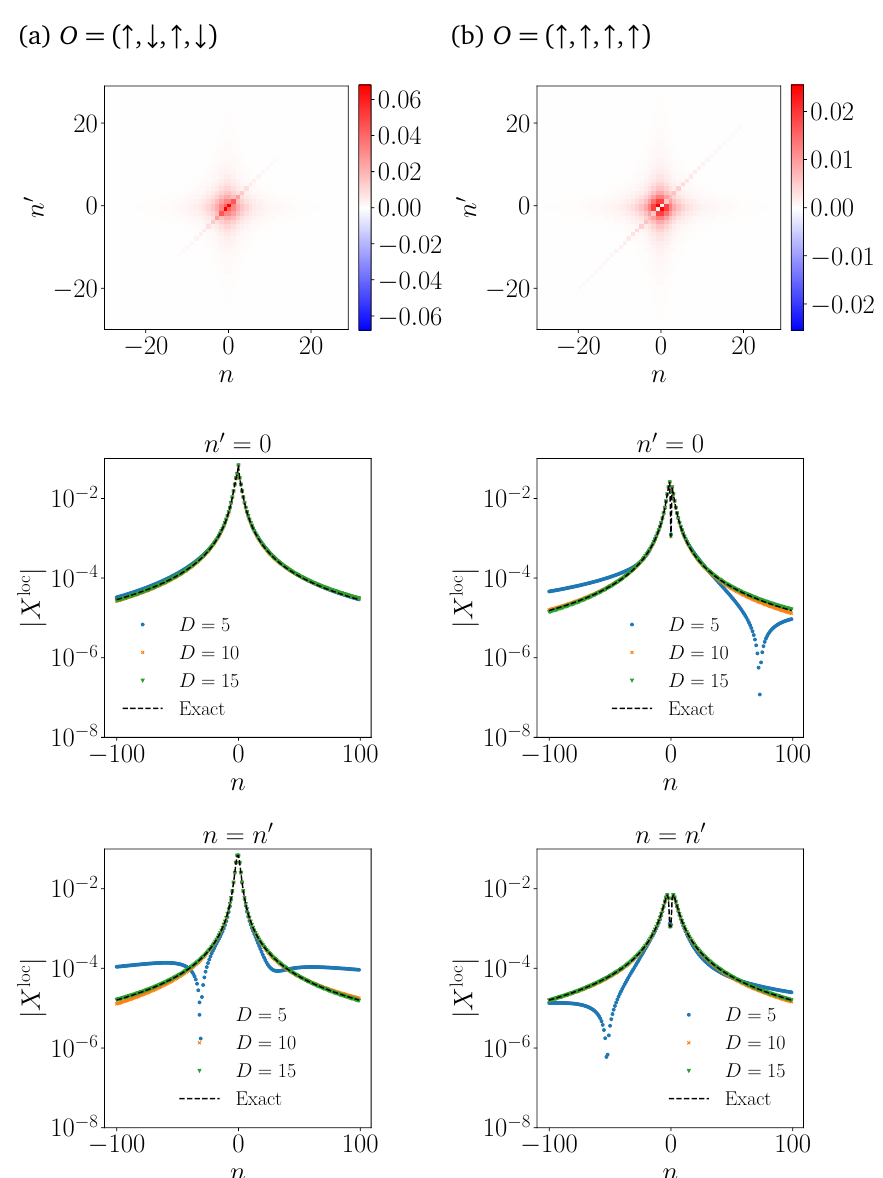
Figure 6: Comparison of interpolated results and exact values of the generalized susceptibility X loc for the single-band Hubbard model. The panels (a) and (b) show the data for O = ( ↑ , ↓ , ↑ , ↓ ) and ( ↑ , ↑ , ↑ , ↑ ) , respectively. The 2D colormaps show the interpolated data for D =